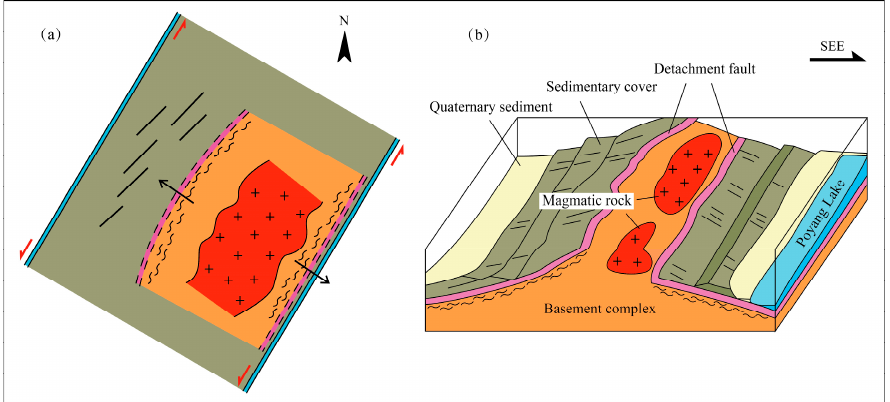
Figure 5. Plane ( a ) and stereoscopic ( b ) sketch of the Lushan area.